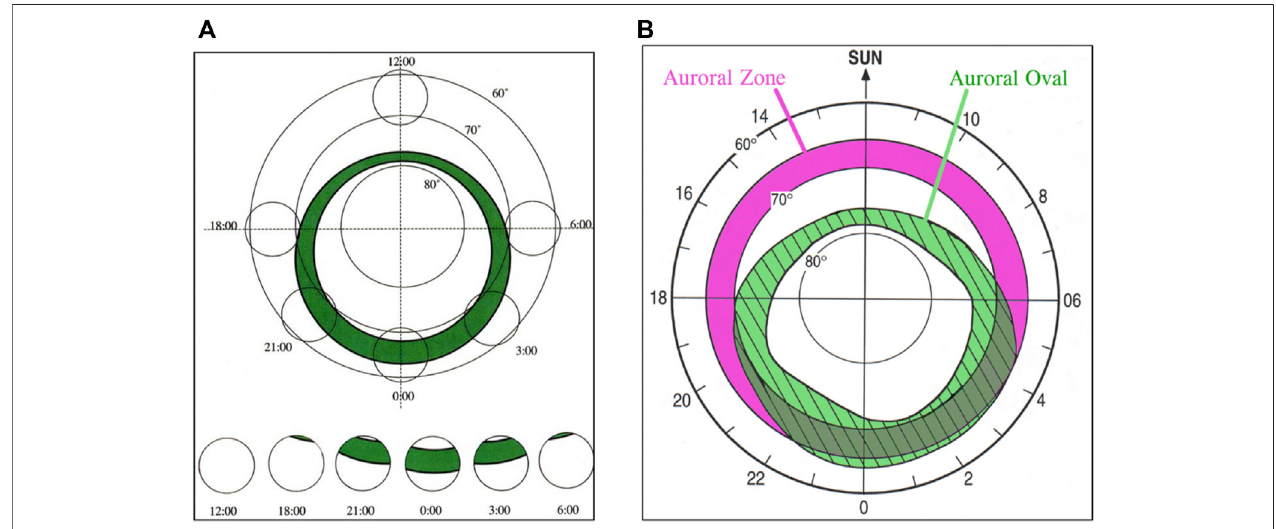
FIGURE4|(A) Auroralbeltimaginedbytheauthor.Theauroraappearedalmostalwaysnearthenorthernandreachedoverheadandrecededinthenorthernskyin morning hours. The circles indicate the fi eld of view in Fairbanks, Alaska. (B) Feldstein ’ s auroral oval (green) and the auroral zone (pink) in MLT coordinate